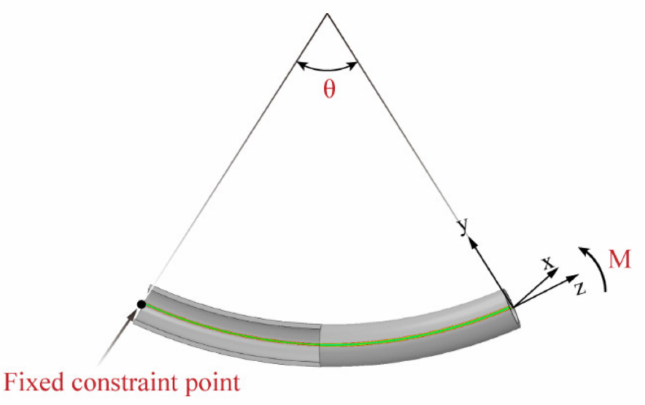
Figure 8. SFEM to simulate bending without tool